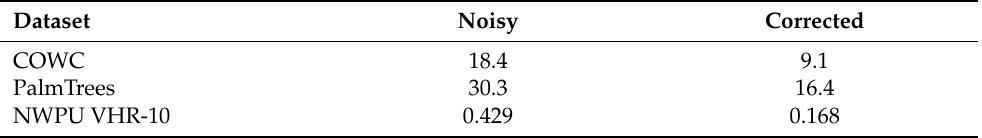
Table 1. RMSE between the noisy and corrected object locations and their closest ground-truth object center. For NWPU VHR-10, we normalized the Euclidean errors (in pixels) with the average box size for each class to prevent classes of larger objects from dominating the class macro average of